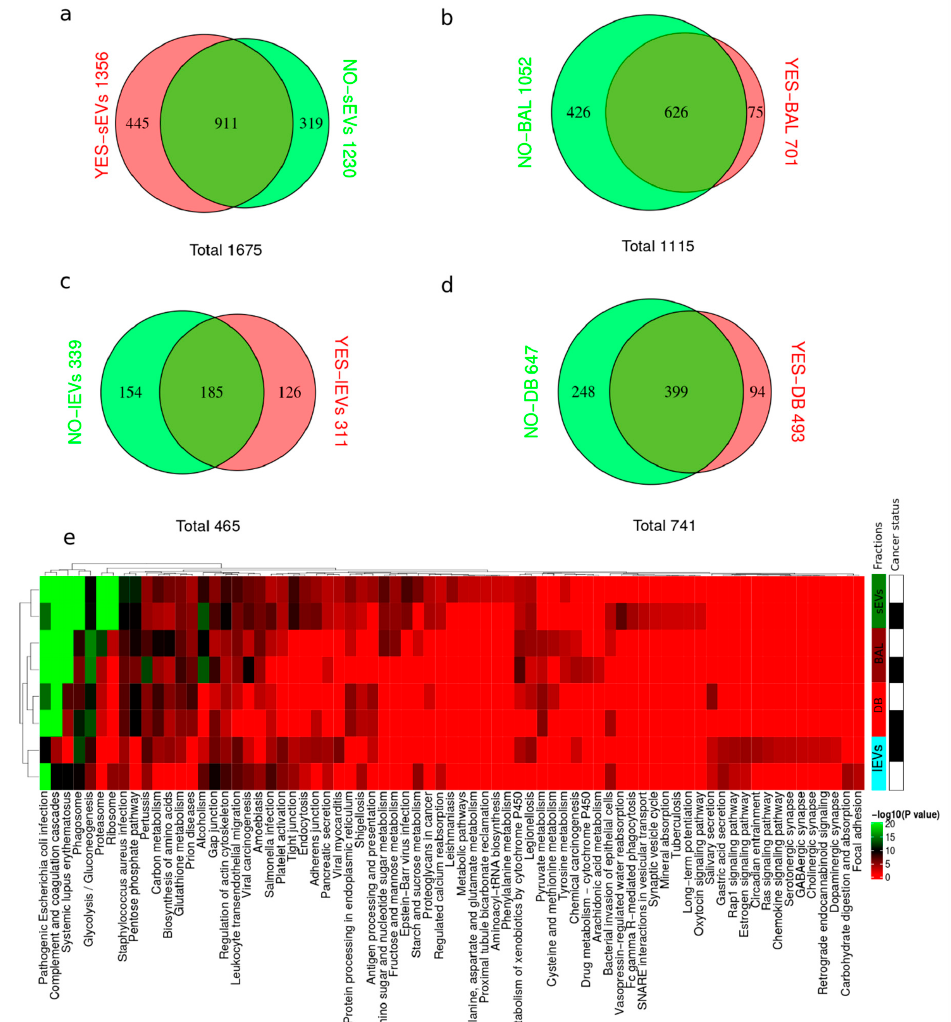
Figure 1. Proteome overview in bronchoalveolar lavage (BAL) fractions. Venn diagrams comparing cancer (YES) versus control (NO) in: ( a ) sEVs, ( b ) BAL, ( c ) lEVs, and ( d ) DB; ( e ) Heat-map of KEGG